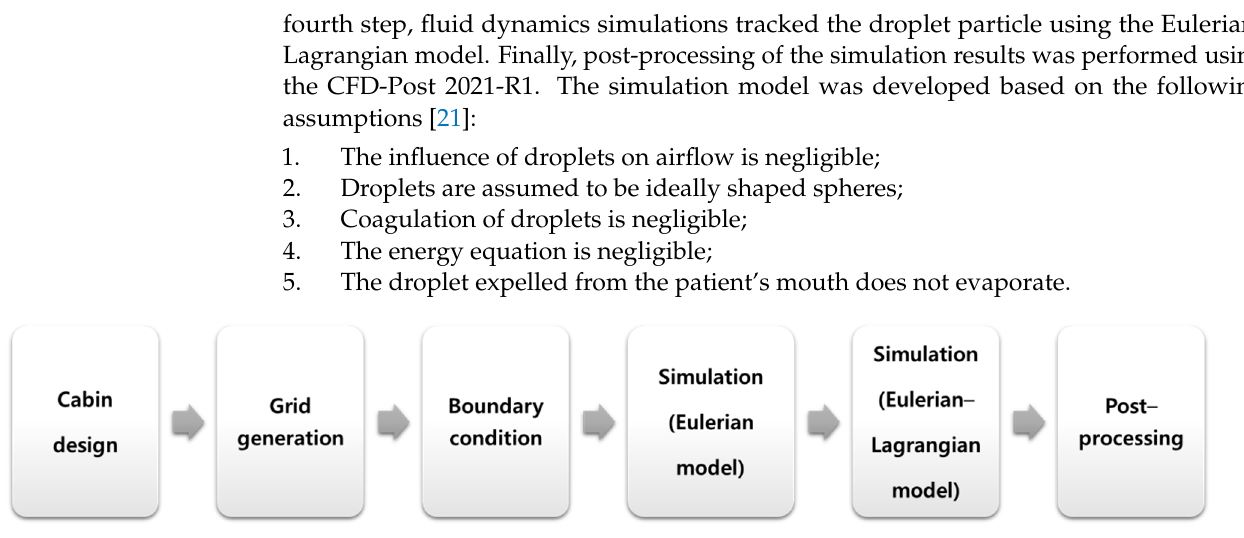
Figure 2. Flowchart of the simulation.